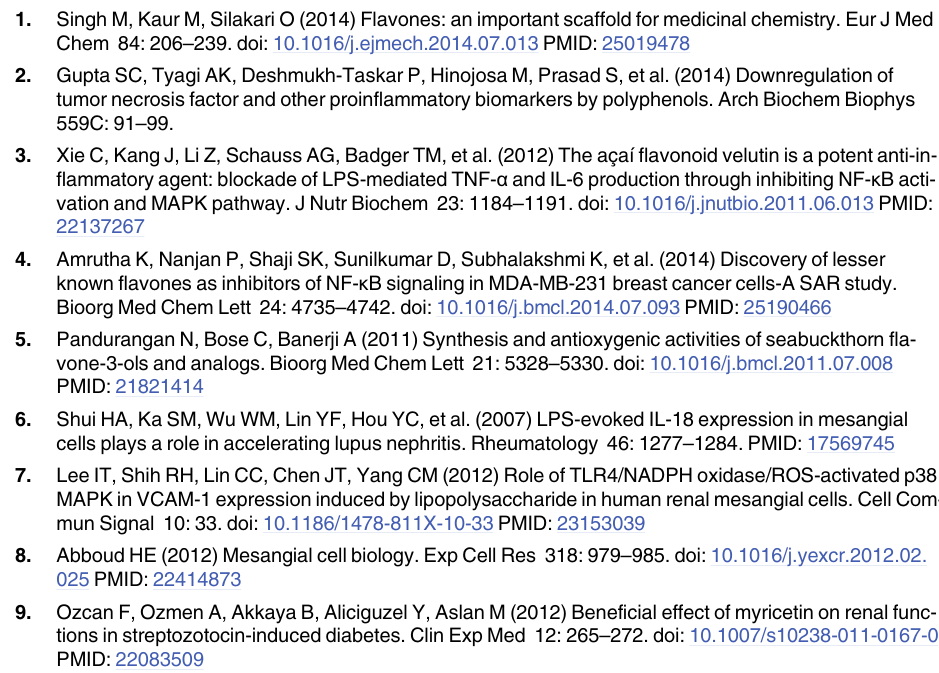
S2 Table. Viability of mesangial cells upon treatment with Group two and three flavones by MTT assay. a MTT assay was carried out after the compound treatment for 48 h and cell viabili- ty was calculated as percentage relative to that of DMSO control. b IC inhibition of the total nitrite production in the presence of 10 ng/mL LPS in mesangial cells after 48 h. S3 Table. Viability of mesangial cells upon treatment with Group four and five flavones by MTT assay. a MTT assay was carried out after compound treatment for 48 h and cell viability was calculated as percentage relative to that of DMSO